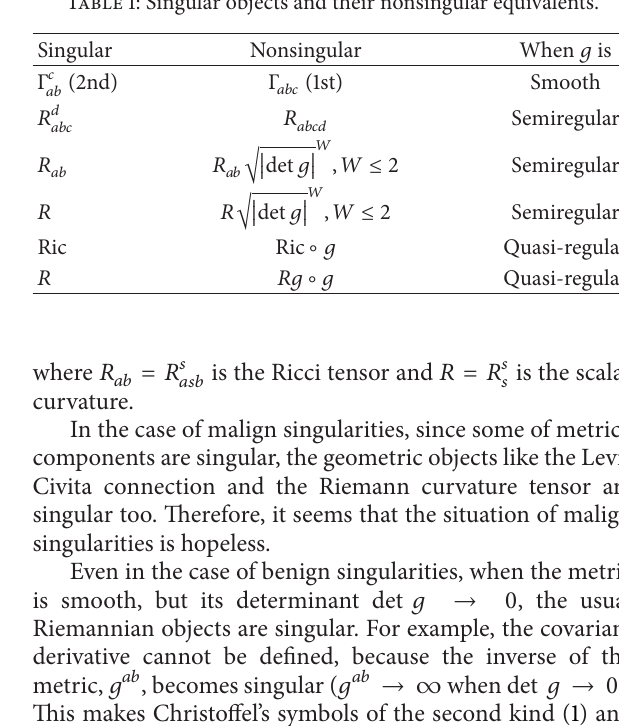
Table 1: Singular objects and their nonsingular